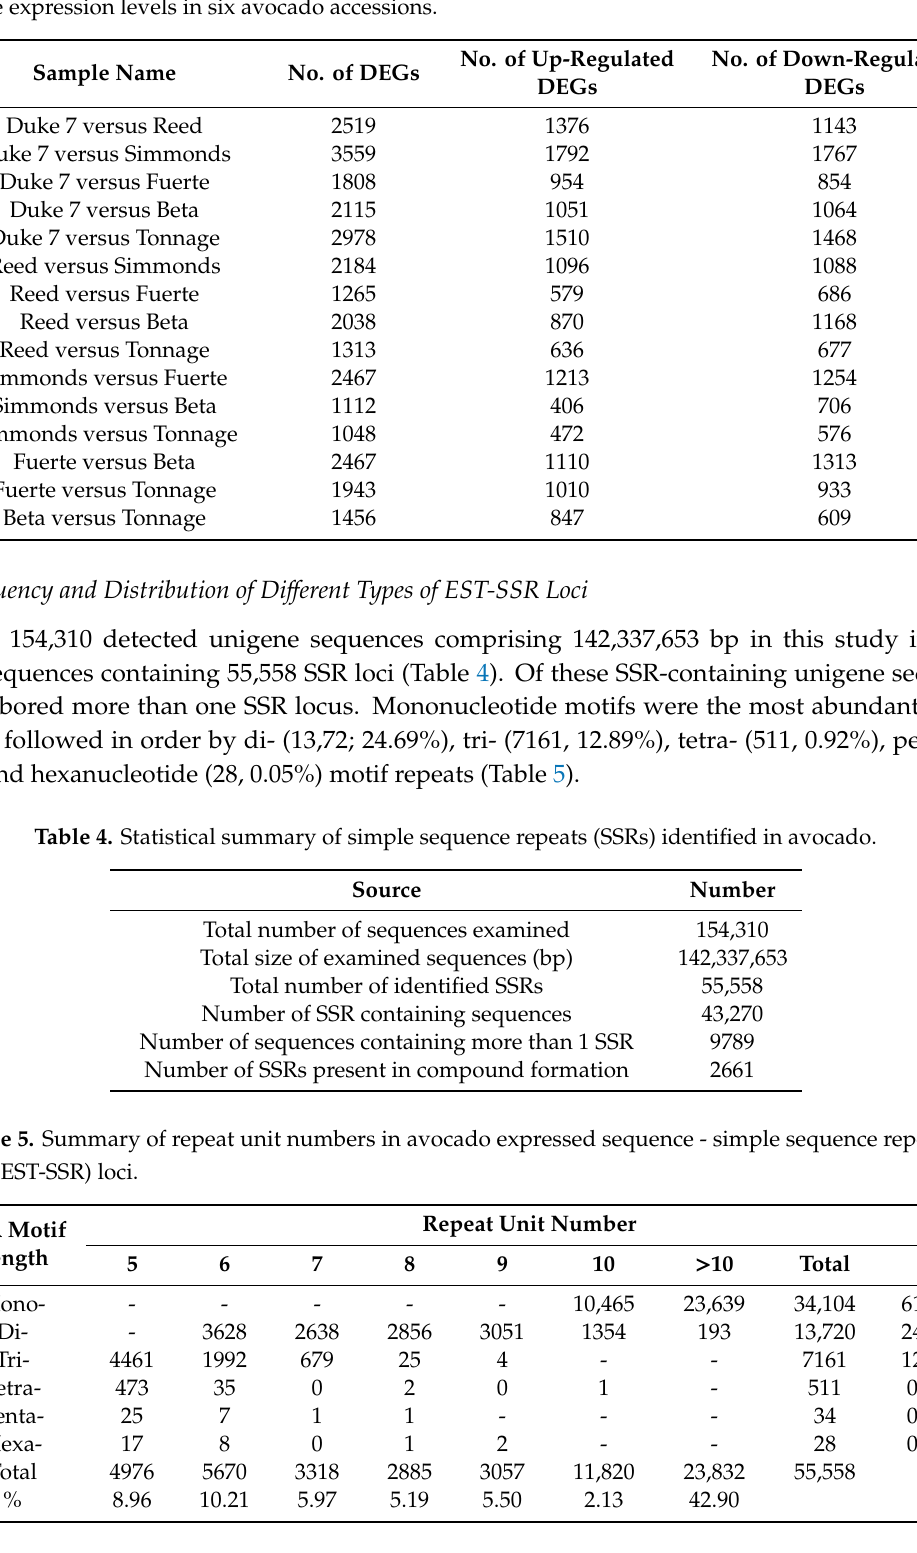
Table 3. The number of di ff erentially expressed genes (DEGs) identified by pairwise comparisons of gene expression levels in six avocado accessions.